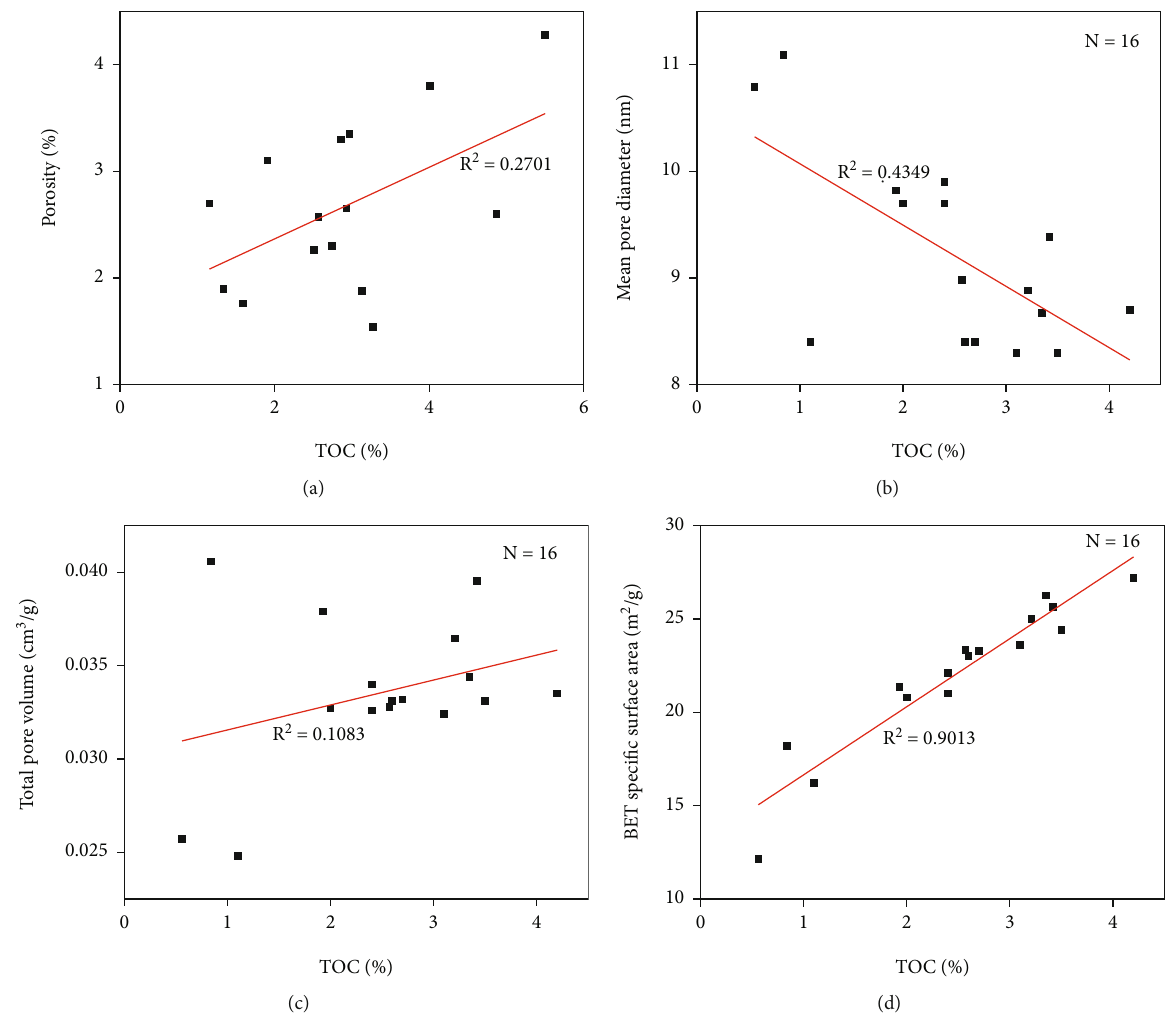
Figure 17: Relationships between the TOC and pore